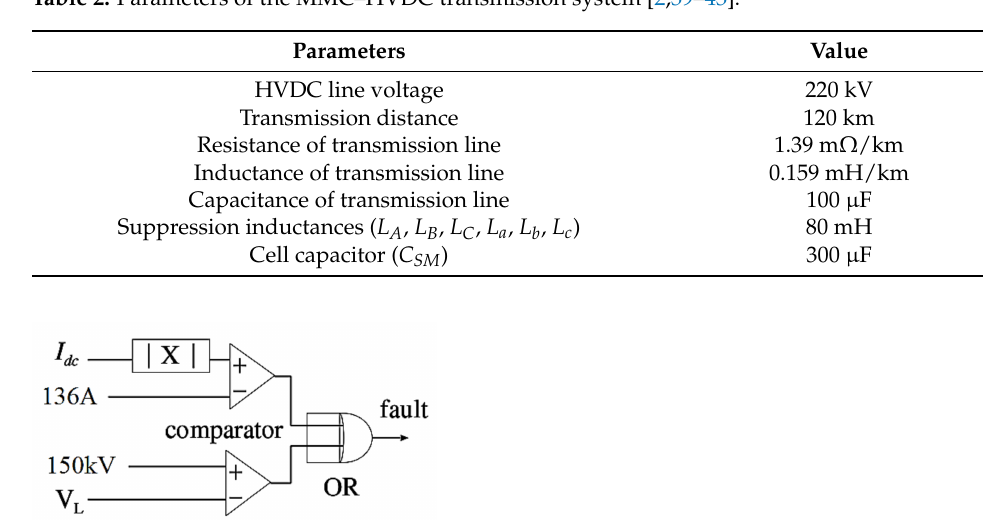
Table 2. Parameters of the MMC–HVDC transmission system [2,39–43].